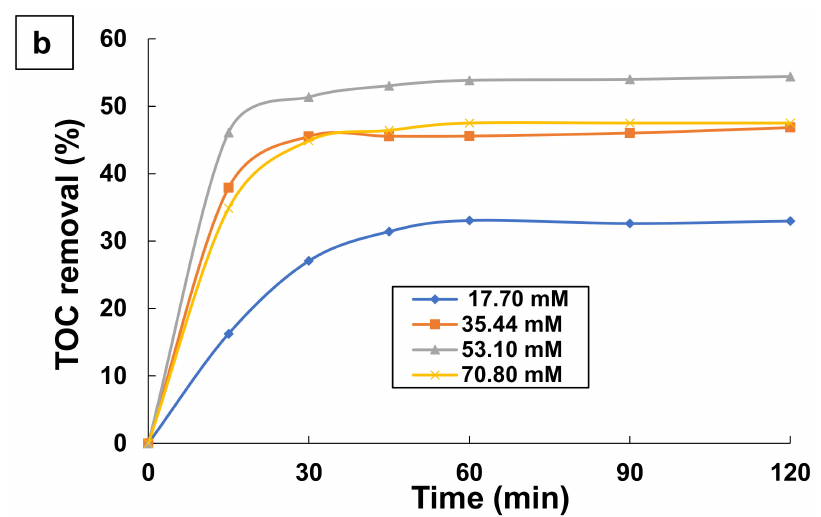
Figure 5. Effect of persulfate dose on the changes with time of: ( a ) Aromatics removal, and ( b ) TOC removal by UV/PS process. Experimental conditions: [TA] = 0.1 mM; [PS] = 17.70–70.80 mM; T = 25 ◦